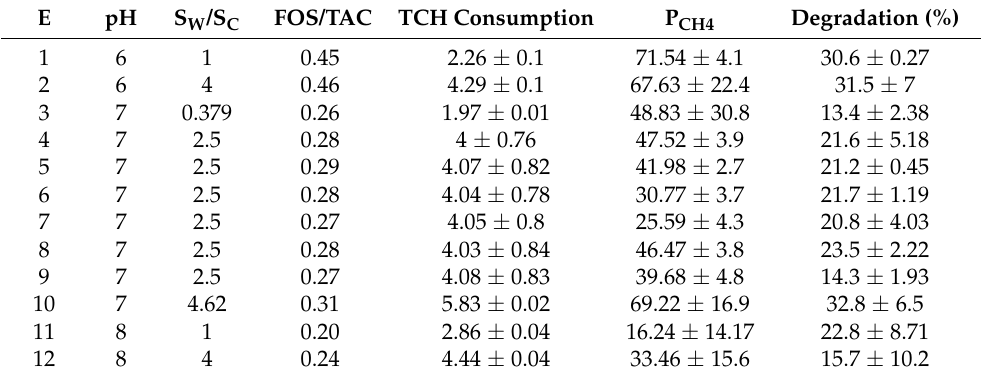
Table 2. Results of the experimental tests of the anaerobic co-digestion of raw cheese whey and coffee pulp residues at 35 ◦ C.